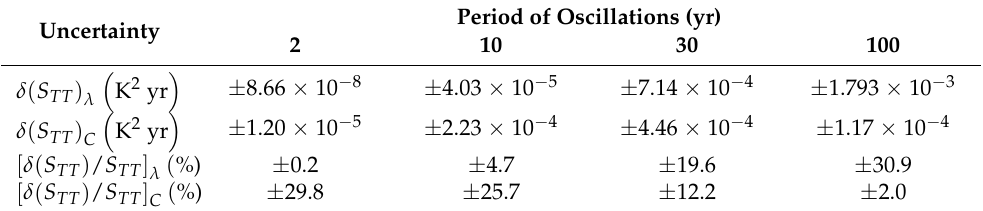
Figure 5. Relative sensitivity functions 𝜓 (cid:3090)(cid:3019) and 𝜓 (cid:3004)(cid:3019) , which were calculated for different values of the feedback coefficient 𝑓 . Table 2. Absolute and relative uncertainties in power spectrum of the GMST fluctuations caused by one-sigma uncertainties in the feedback parameter λ and the climate system inertia parameter C .